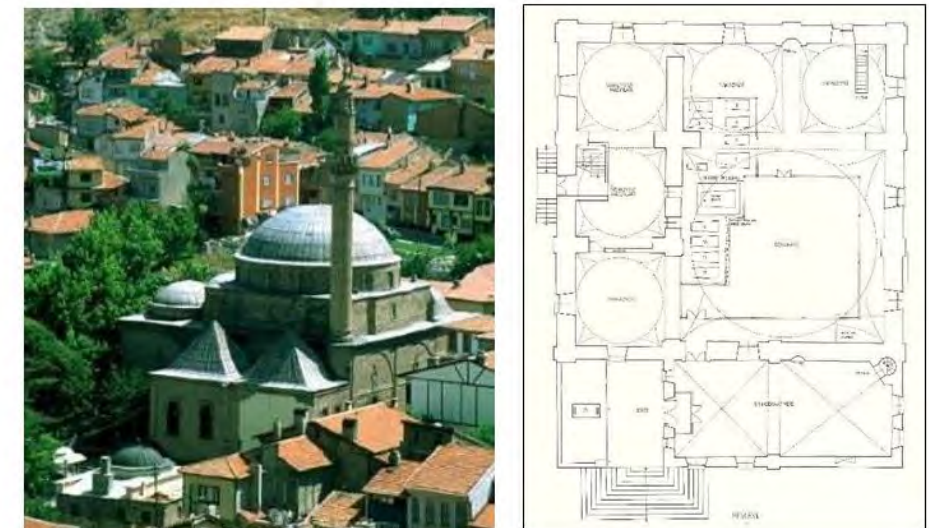
Figure 3. Mevlevihan of Afyonkarahisar/Example of Mosque - Tekke (Ilgar, 2012)